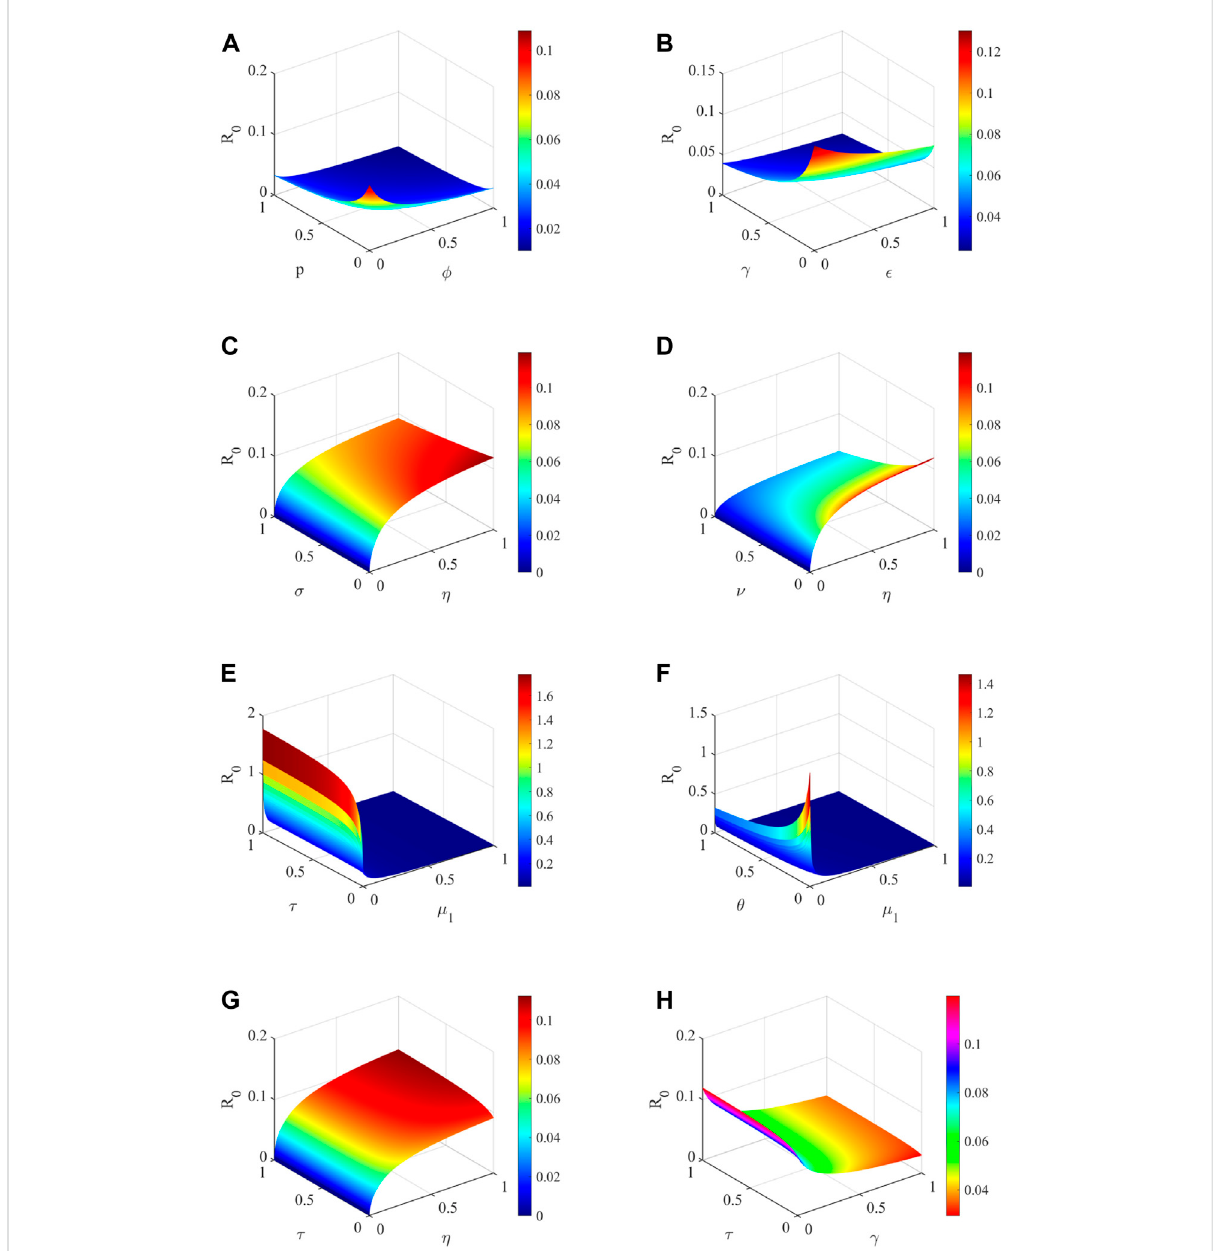
Sensitivity analysis of different parameters. (A) R 0 versus sensitive parameters p and ϕ , (B) R 0 versus sensitive parameters γ and ϵ , (C) R 0 versus sensitiveparameters σ and η , (D) R 0 versus sensitiveparameters ] and η , (E) R 0 versus sensitiveparameters τ and μ 1 , (F) R 0 versus sensitiveparameters θ and μ 1 , (G) R 0 versus sensitive parameters τ and η , (H) R 0 versus sensitive parameters τ and γ